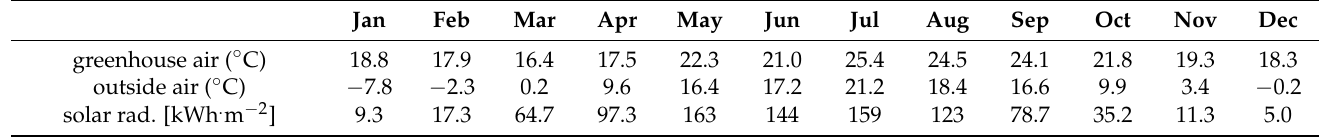
Table 3. Average monthly air temperature inside and outside the GH, and monthly sums of solar ra- diation for the town of Skierniewice (to download raw sampling data, see Supplementary